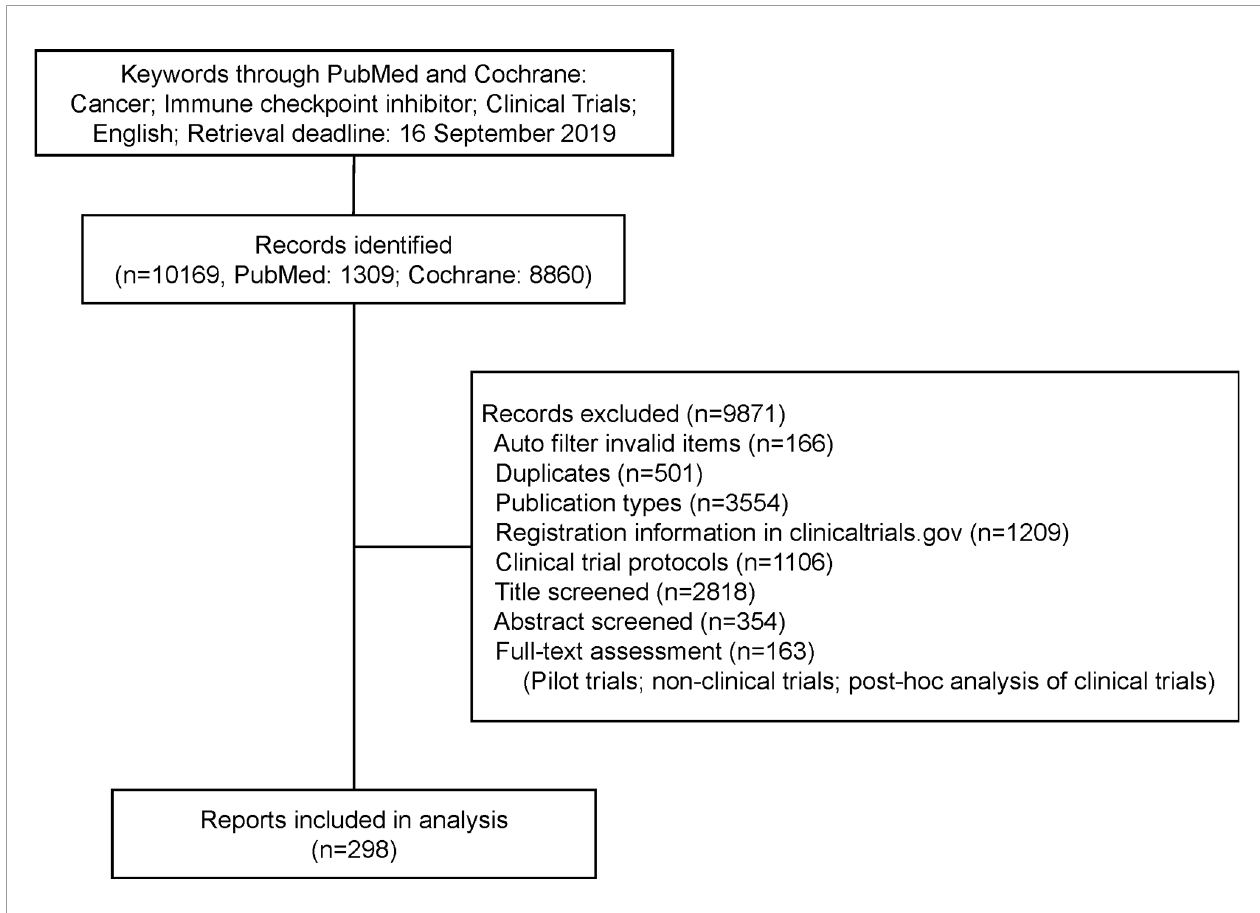
FIGURE 1 | Flowchart. Identifying reports on immuno-oncology clinical